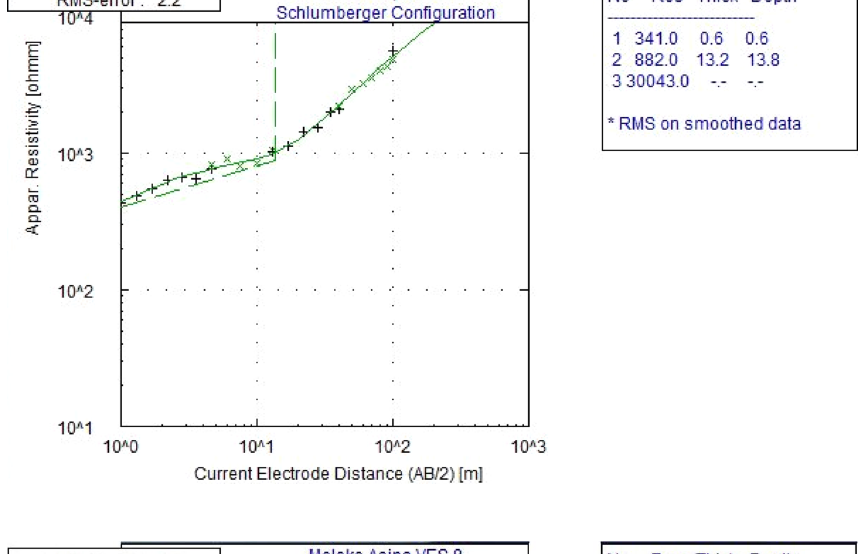
Fig. 17 Layer model interpreta- tion for VES